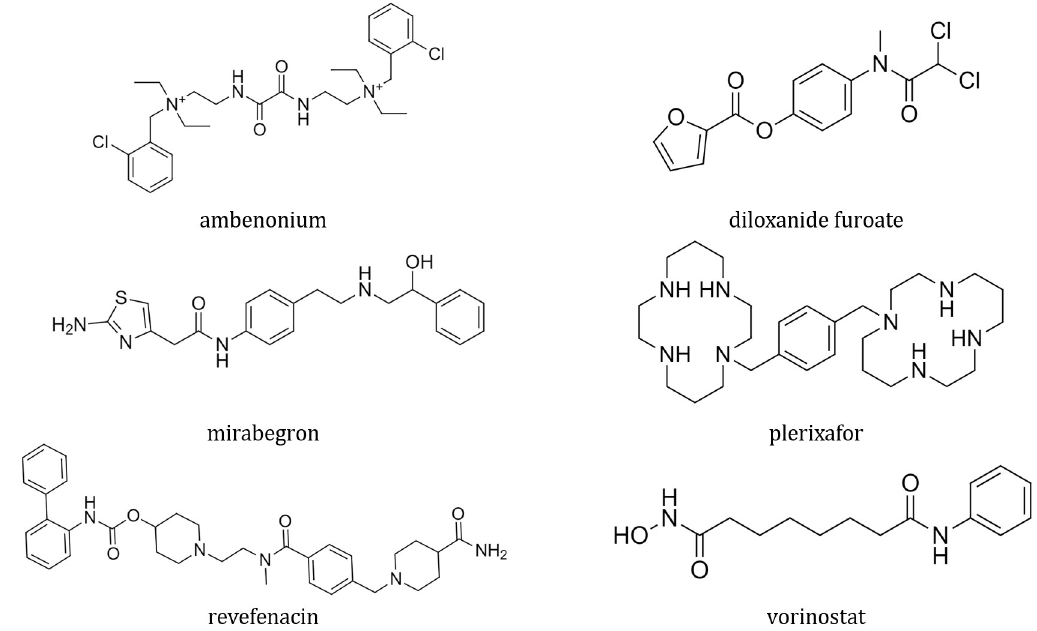
Fig 2. Compounds highlighted by docking assay. The 2D structure of the best scored ligands in docking